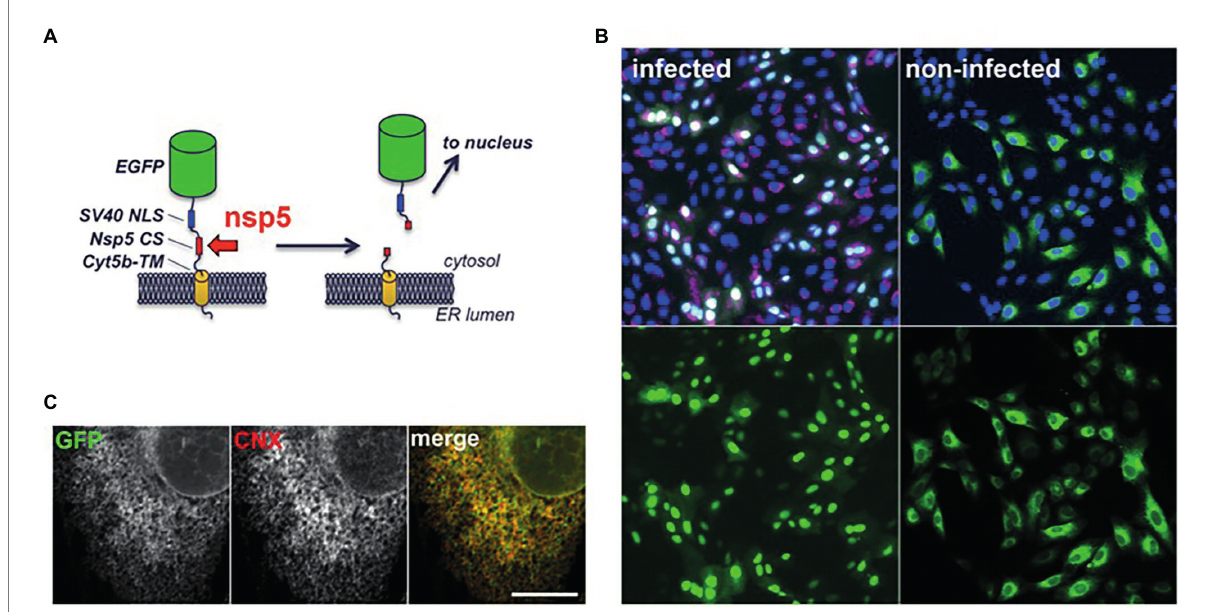
FIGURE 2 Structure and intracellular localization of a fluorescent SARS-CoV-2 reporter. (A) Scheme of the fluorescent reporter. EGFP: enhanced GFP (green), NLS: nuclear localization signal (blue), CS: cleavage site (red), cyt5b TM: cytochrome 5b transmembrane domain (yellow). (B) Vero-81-derived clone 6 cells expressing the fluorescent reporter (green) were infected with SARS-CoV-2 (left panels) or left non-infected (right panels). Cells were fixed and processed for immunofluorescent detection of dsRNA (red) and DAPI staining (blue) at 16 hpi. Same fields are shown with combined fluorescent signals (top) or with GFP signal only (bottom). (C) Confocal image of an non-infected clone 6 cell expressing the fluorescent reporter (GFP) immunolabeled with an antibody to calnexin (CNX). Individual channels are shown in grayscales for a better display and combined images in colors in the right panel. Bar, 10 μ